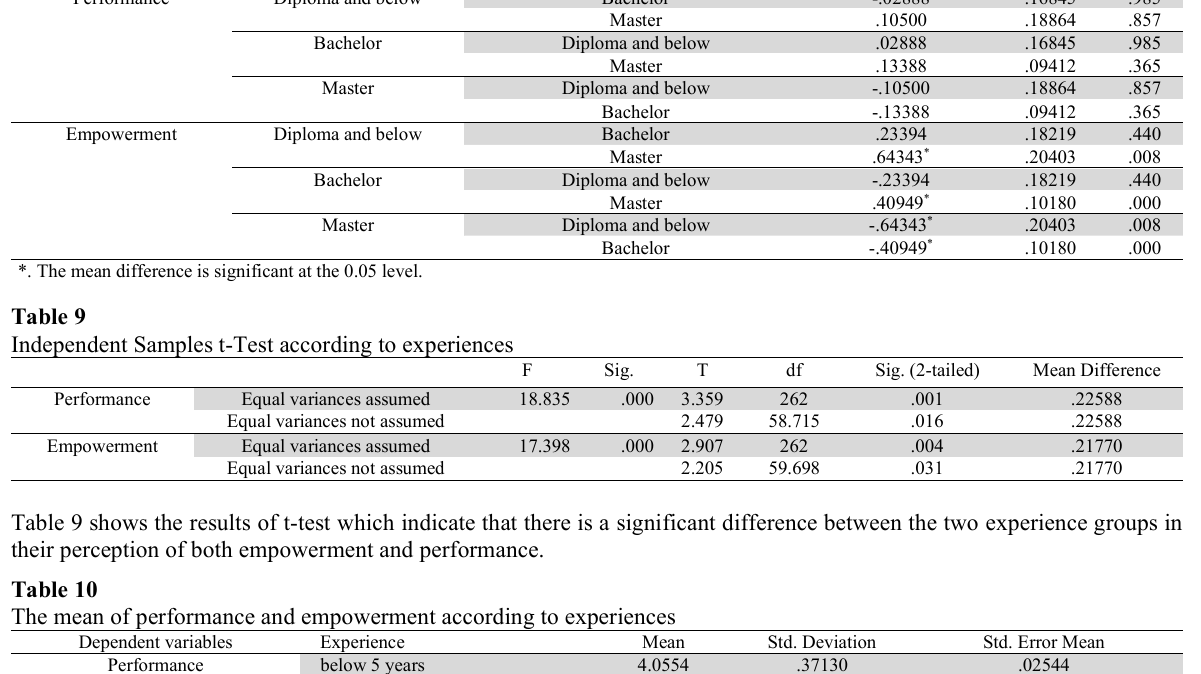
Scheffe analysis according to qualification level Dependent Variable